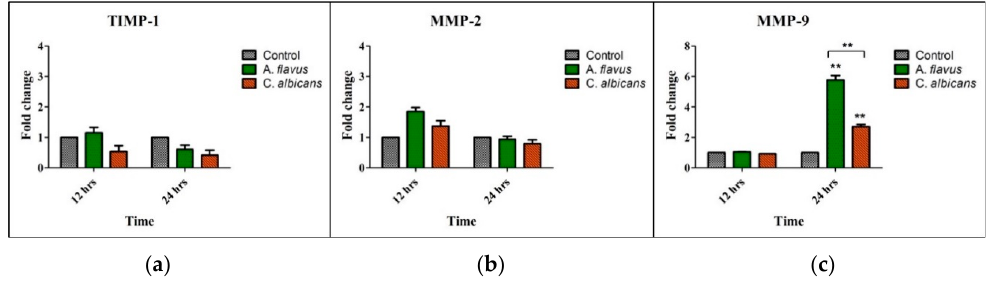
Figure 3. CHME-3 cells were challenged with A. flavus and C. albicans at indicated time points. The bar graphs show that there is no significant expression of ( a ) Tissue Inhibitor of Metalloproteinase-1 (TIMP-1) and ( b ) Matrix metalloproteinase-2 (MMP-2) in CHME-3 cells infected with A. flavus and C. albicans . ( c ) Significantly elevated expression of MMP-9 was observed in CHME-3 cells challenged with A. flavus and C. albicans compared with control. Data shown are the mean standard errors of three independent experiments performed in triplicate ** p < 0.005.